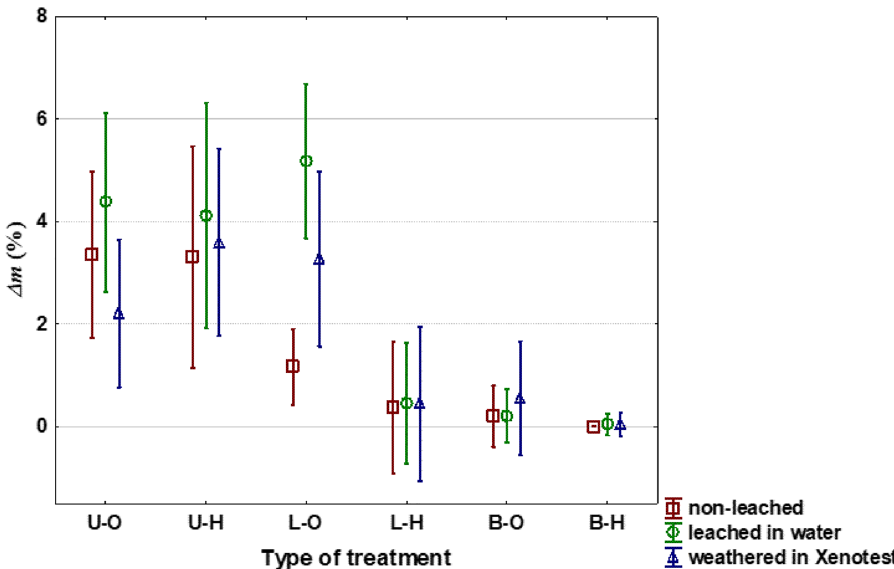
Figure 1. Mass losses (Δm) of the Norway spruce wood samples after 6-weeks attack by termites Reticulitermes flavipes . Untreated original—(U–O); Untreated, but with the additional hydrophobic substance—(U-H); Treated with the lavender oil—(L-O); Treated with the lavender oil and then with the hydrophobic substance (L-H); Treated with the Bochemit QB—(B-O); Treated with the Bochemit QB and then with the hydrophobic substance—(B-H).